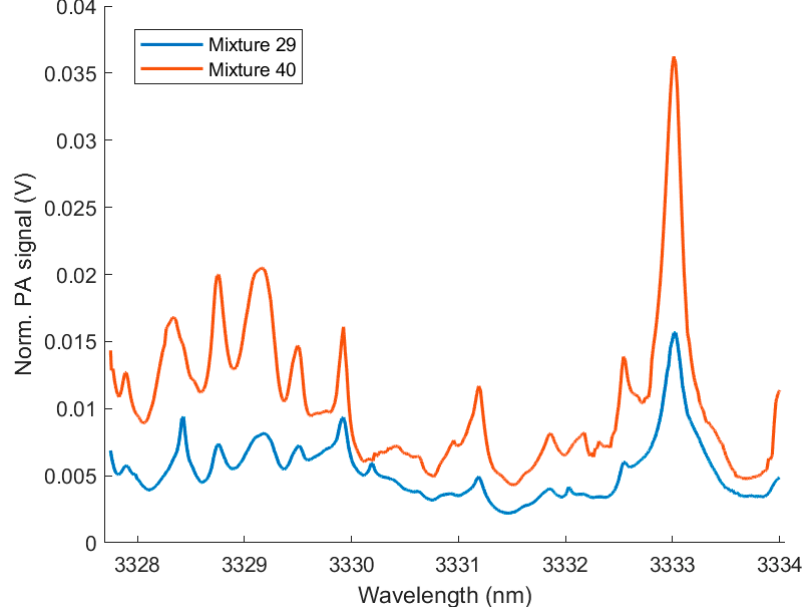
Figure 5. PA spectra measured with ICL 1638 of sample gases with concentrations according to Table 2.